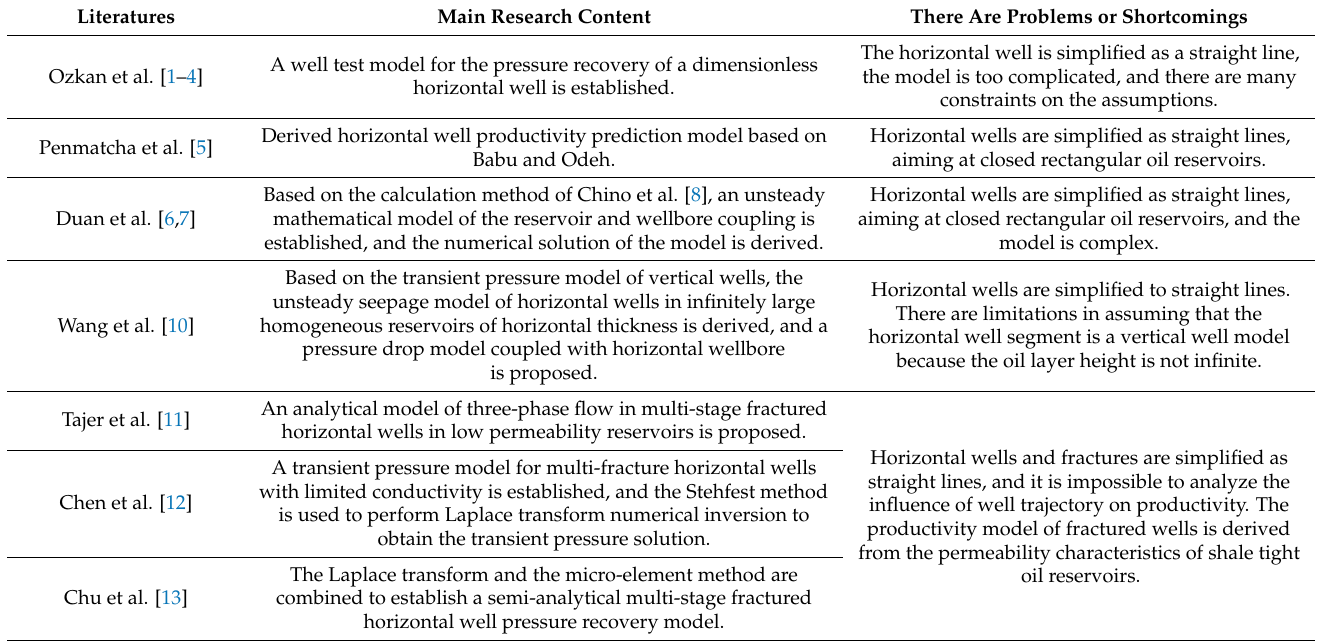
Table 1. Statistical analysis of research